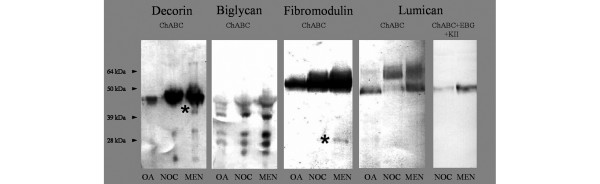
Western blot. Western blot analysis of decorin, biglycan, fibromodulin and lumican in extracts of human osteoarthritis cartilage (OA), nonoperated control (NOC) and lateral meniscectomized (MEN) ovine cartilage samples. Core protein fragments of decorin and fibromodulin that were only identified in MEN are marked with an asterisk. Equivalent amounts of extract from equal dry weights of tissue were loaded per lane following treatment with chondroitinase ABC (ChABC). Additionally, Western blot analysis of lumican was performed following treatment with ChABC, endo-β-galactosidase (EBG) and keratanase II (KII). The migration positions of prestained protein standards are indicated on the left.